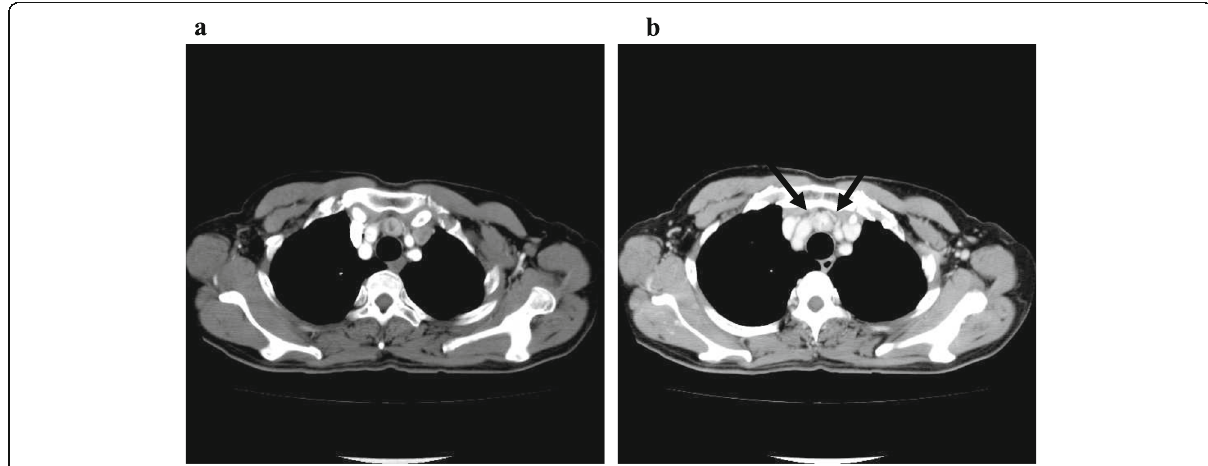
Fig. 1 Contrast-enhanced CT images of ectopic mediastinal thyroid tissue. a Poor enhancement with a low density of the central region in the early phase. b Strong enhancement, especially of the central region, in the delayed phase. Arrows show tumor-feeding arteries arising from the vessels in the